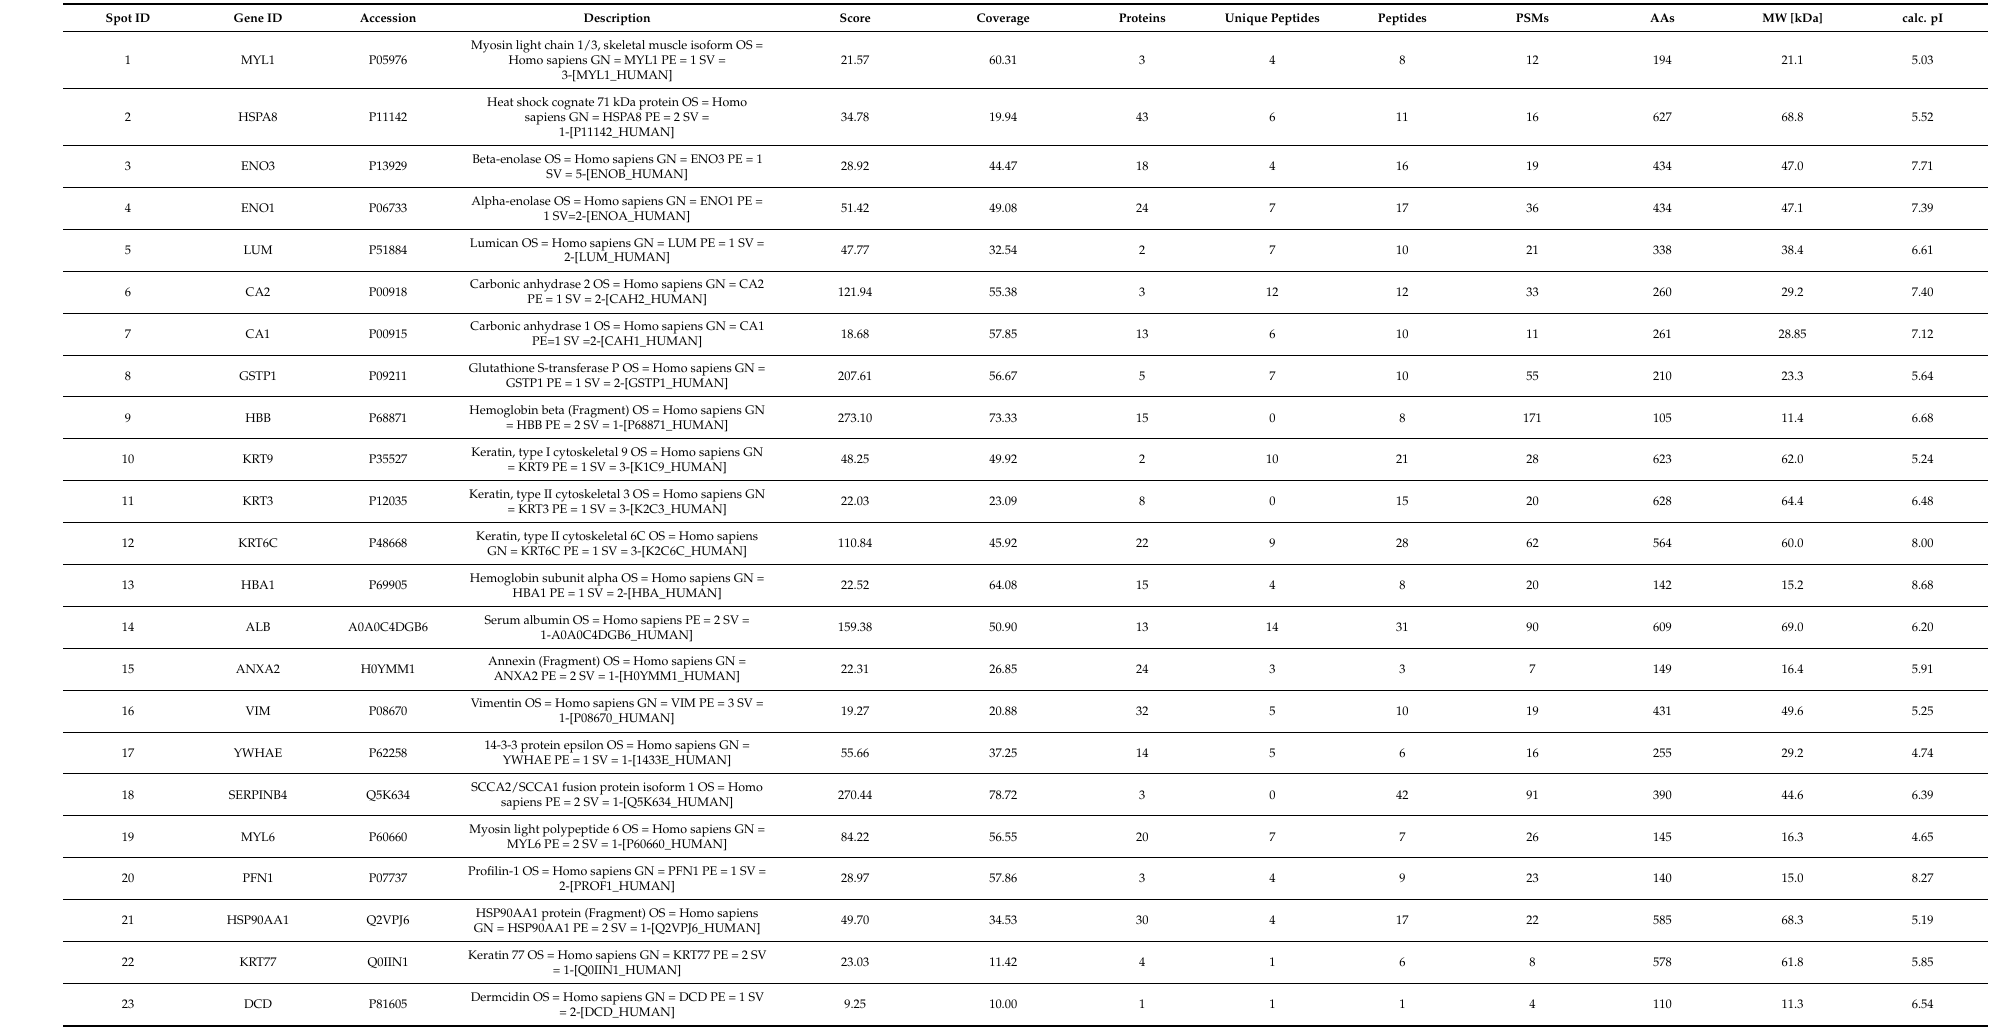
Table 1. List of upregulated proteins between OSMF, OSCC and normal tissues identified using